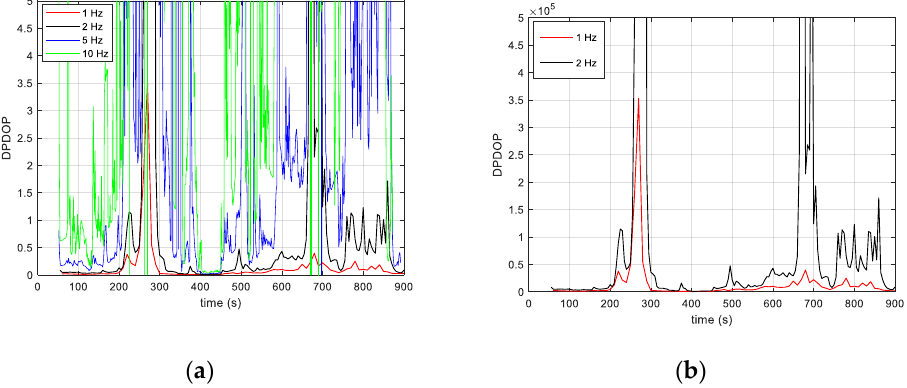
Figure 13. ( a ) Doppler position dilution of precision as a function of time for different values of the